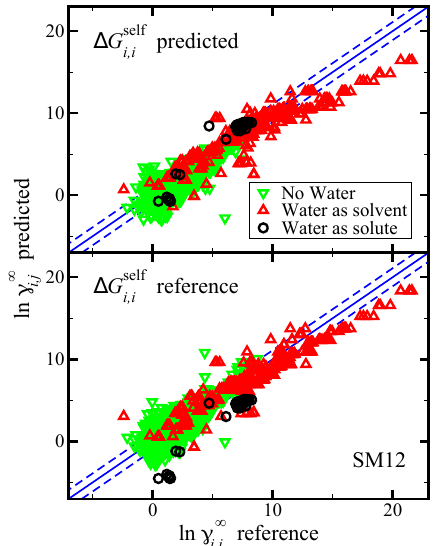
Figure 6. Parity plot of the predicted versus reference values of ln γ ∞ are made using the SM12, SM8, and SMD universal solvent model, as indicated. The blue lines corresponds to the y = x line, and the dashed blue lines correspond to ± 1.1 and are drawn as a reference. In the top pane we present results when ∆ G self universal solvent model. In the bottom pane we present results when ∆ G self reference vapor pressure data.